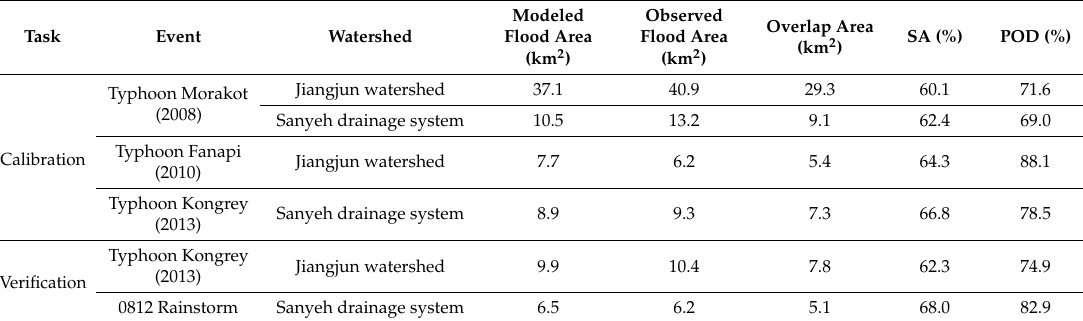
Table 5. Results from the model calibration and verification work.